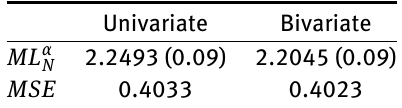
Table 6: Mean squared error and mean length of prediction intervals for predictions based on the univariate and the bivariate method. The means are taken on N = 100 predictions and α = 5% . The number in parenthesis is the proportion of observed values outside prediction